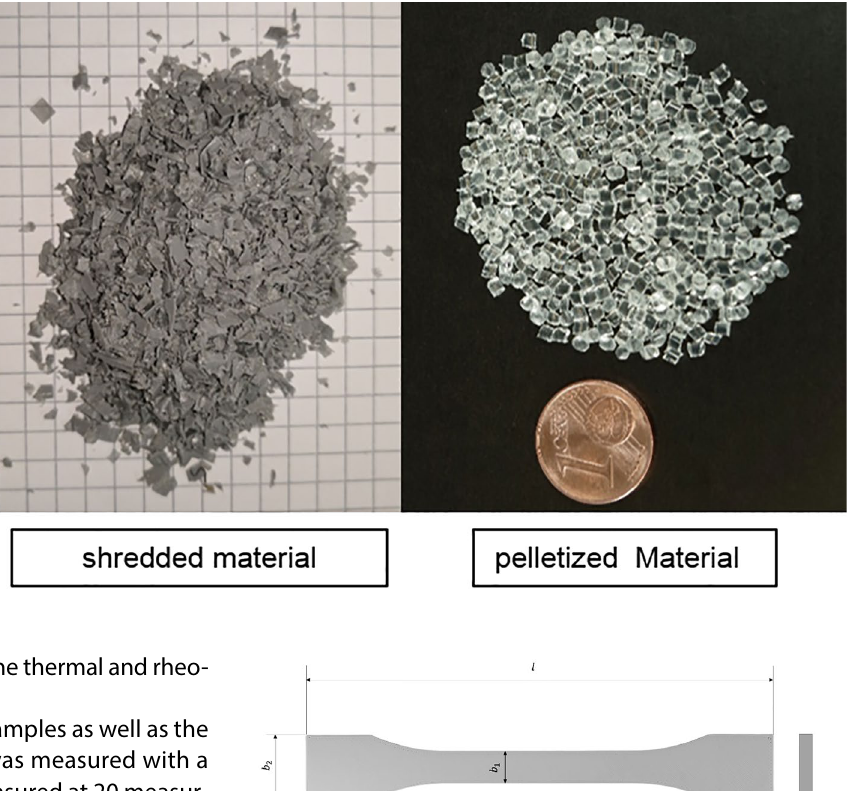
Fig. 4 Difference between shredded (left) and pelletized material (right). The materials had different starting colors